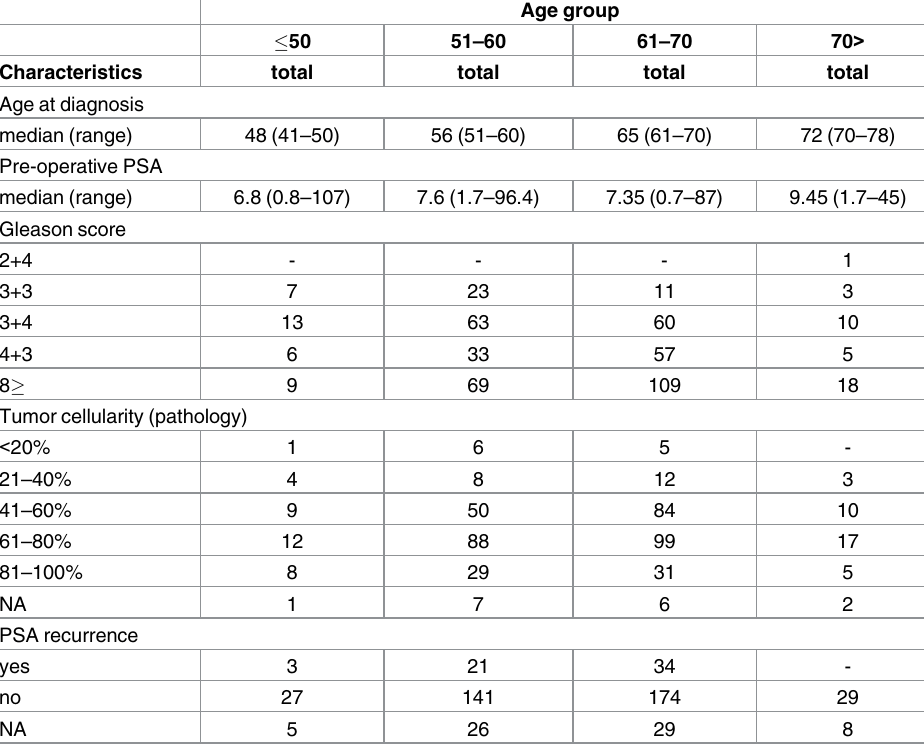
Table 5. Clinical characteristics of PRAD cohort with specification by age